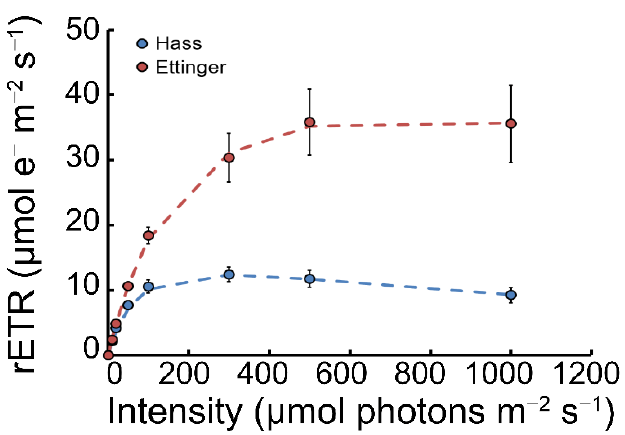
Figure 4. Response of the relative electron transport rate (rETR) of Hass (blue) and Ettinger (dark red) avocado ( P. americana Mill.) cultivars to light at non-stressed conditions. The connecting dashed lines are the averaged statistical fit on each of the respected set of points (R 2 > 0.98). Error bars represent standard error of the